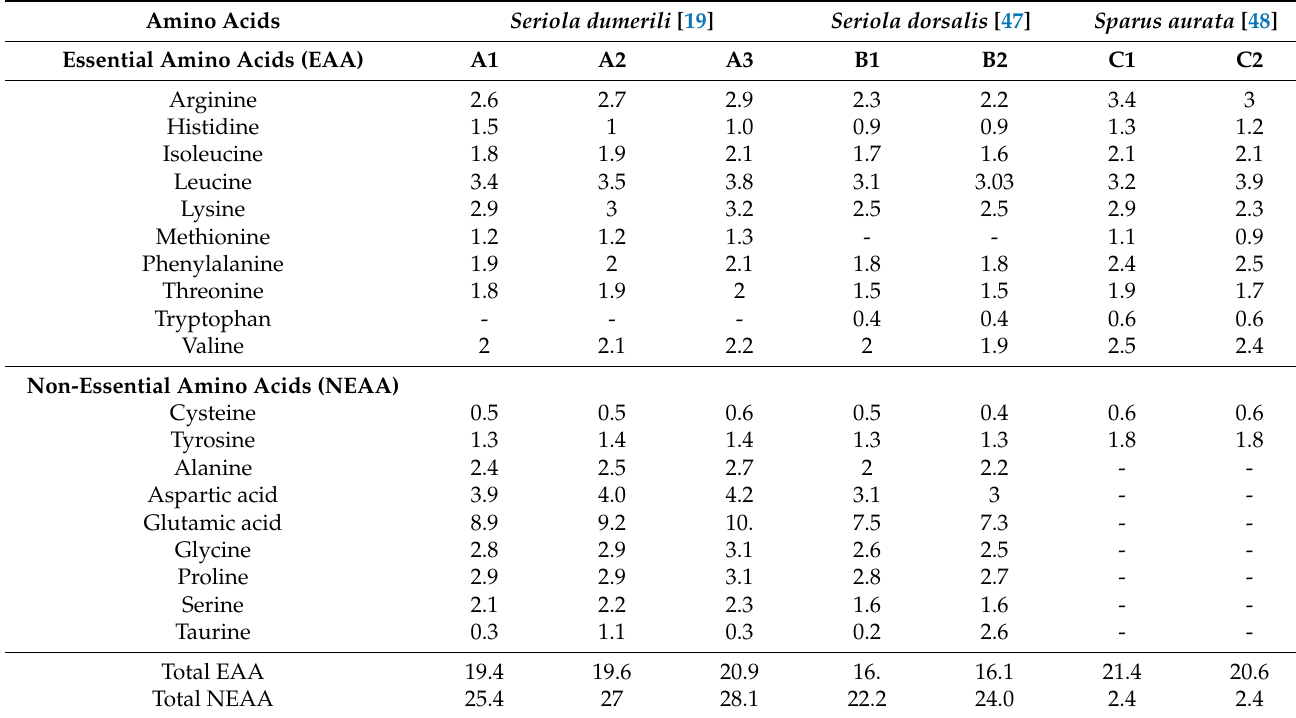
Table 4. Amino acid content and composition (% dry matter) in different experimental diets for